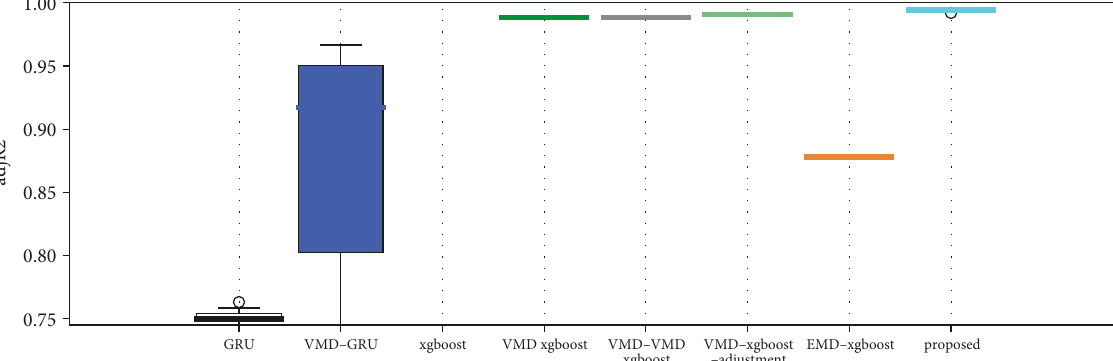
Figure 5: The boxplot figures for each benchmark model in terms of inflow and outflow flow series. The 30 values of adjR2 criterion are selected to plot boxplot figures. The 8 boxes for each dataset correspond to the models in sequence: GRU, VMD-GRU, xgboost, VMD- xgboost, VMD-VMD-xgboost, VMD-xgboost with residual adjustment, EMD-xgboost, and the proposed approach. The boxplot figures of xgboost model are omitted because its results have a large gap compared with other models (inflow: 0.6597, outflow: